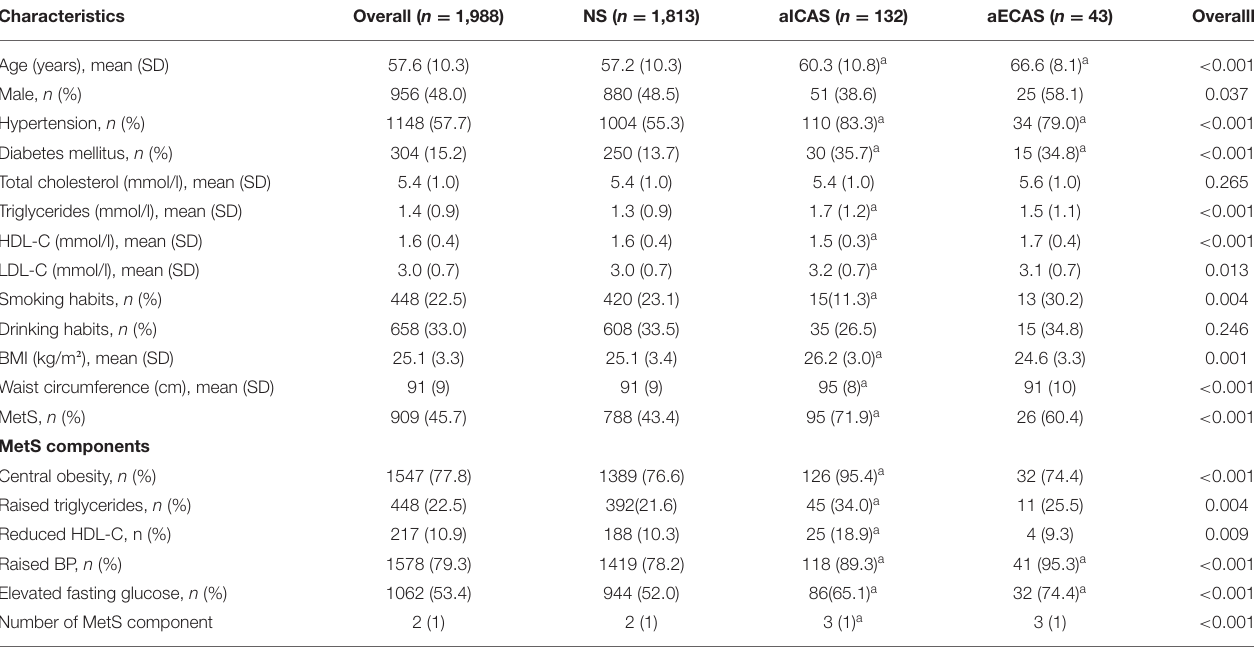
TABLE 1 | Demographic and clinical characteristics of study participants.